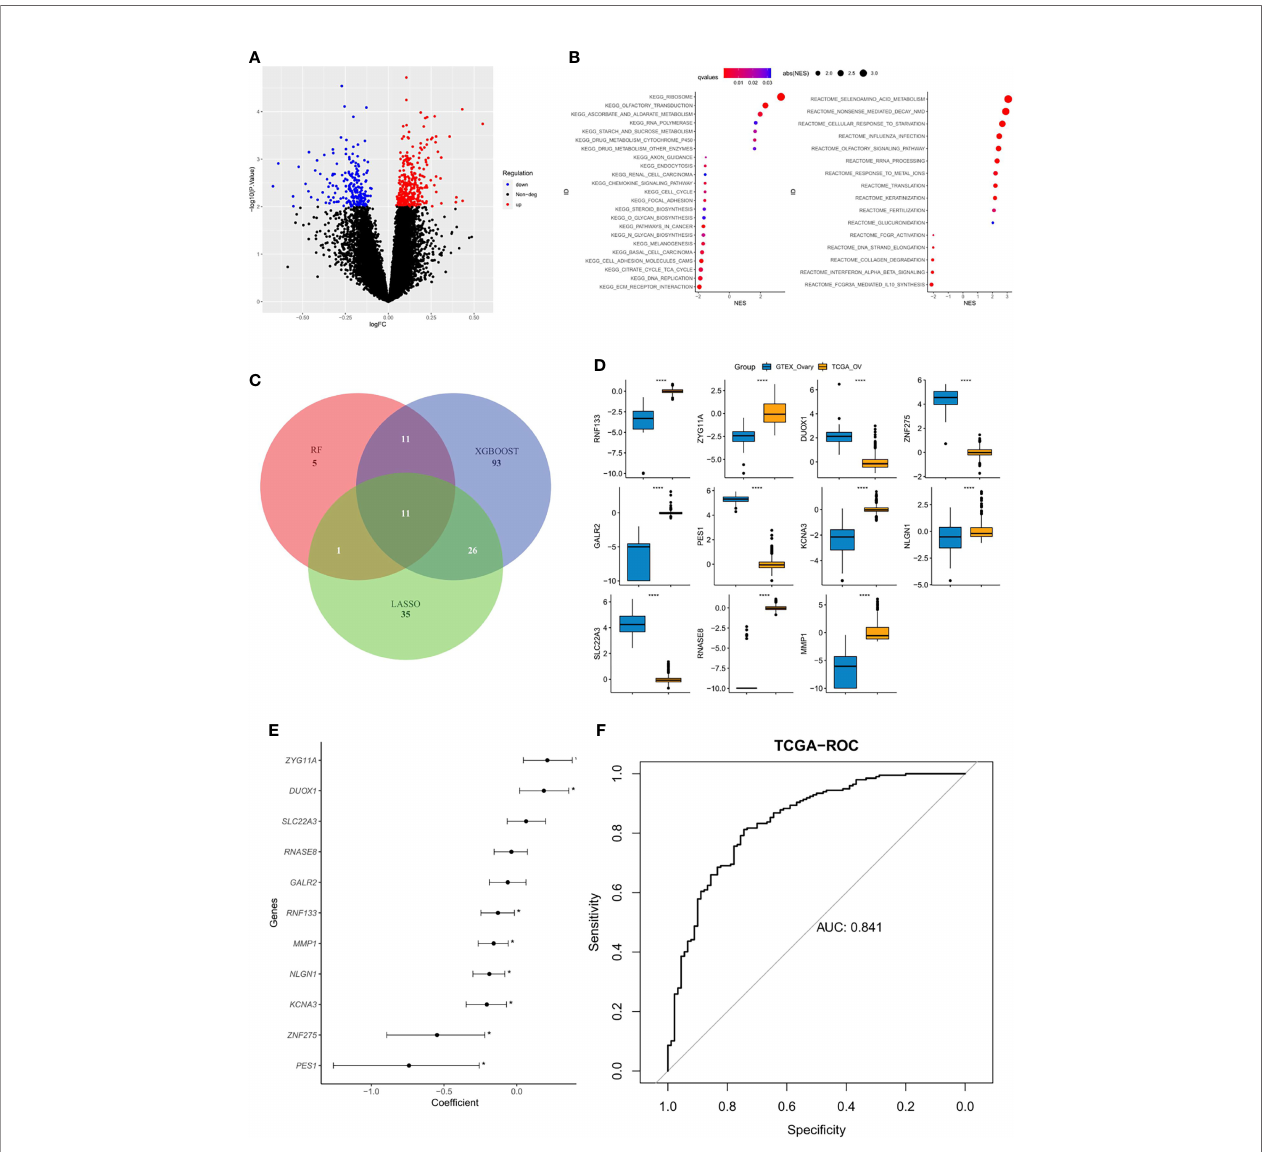
FIGURE 1 | Construction of an IPR signature in the training cohort (TCGA-OV). (A) Differentially expressed genes (DEGs) between platinum-sensitive and platinum- resistant samples. (B) Enriched functional pathway of platinum sensitivity-related DEGs. (C) Venn diagram revealed the overlapping candidate genes of XGBoost, random forest (RF), and least absolute shrinkage and selection operator (LASSO). (D) The expression level of the 11 candidate DEGs between normal ovarian cells (GTEX) and tumor tissues (TCGA), **** p < 0.00001. (E) Correlation between each candidate DEG and the platinum sensitivity, * p < 0.05. (F) The prediction ef fi cacy of the established model in the training